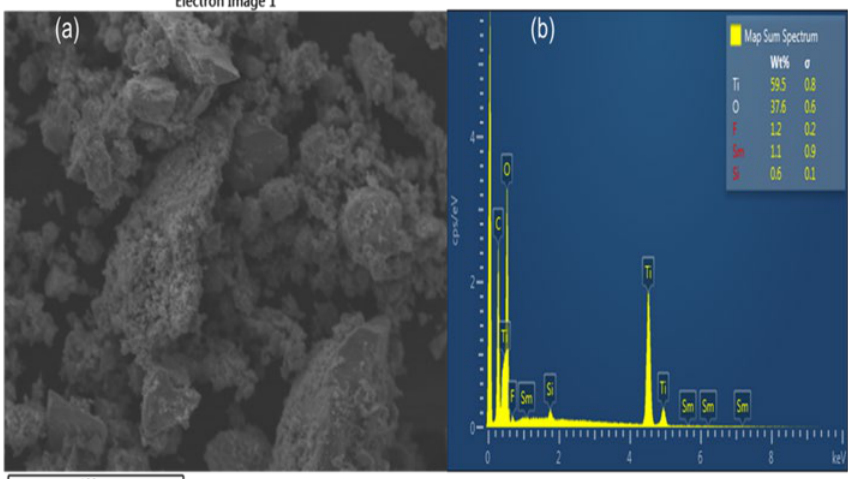
Figure 2. SEM/EDX images of FST3/C1: ( a ) SEM micrograph; and ( b ) EDX